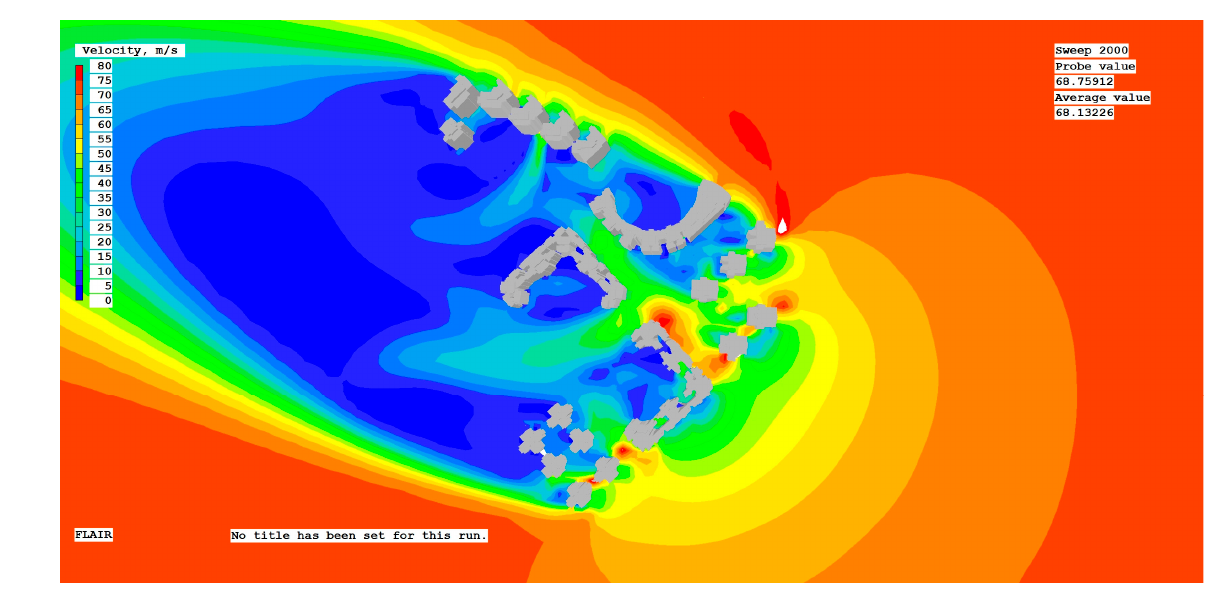
Figure A18. Wind speed distribution under typhoon conditions (50 m height).